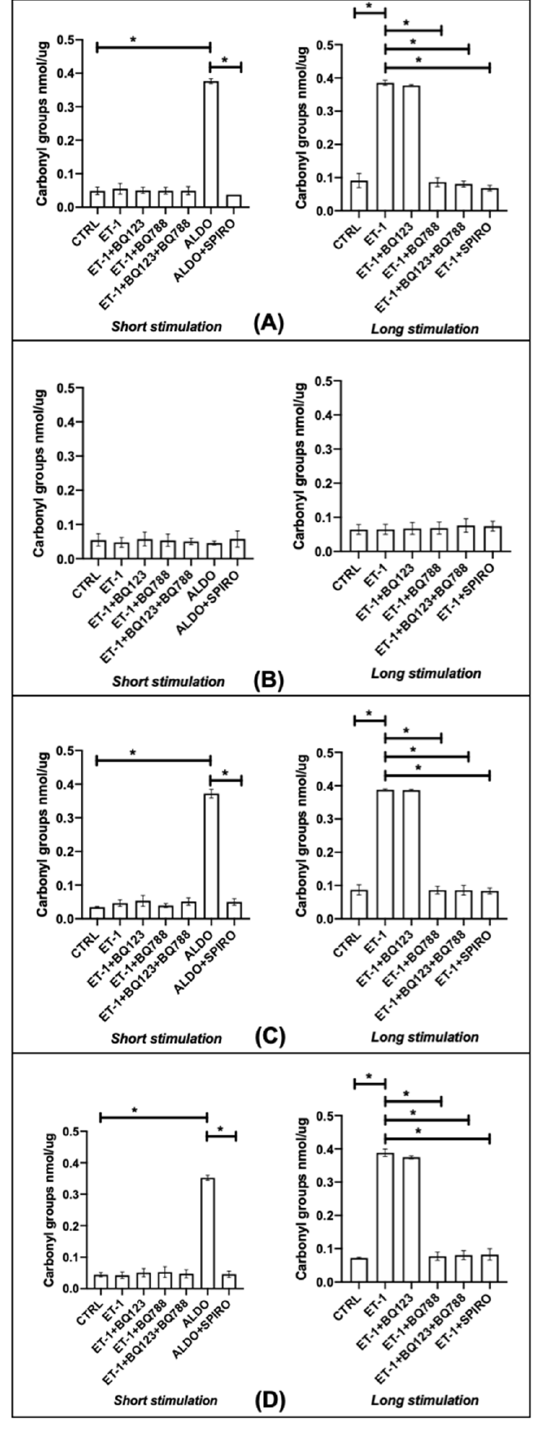
Figure 6. Protein carbonyl content assay in ( A ) HPFs, ( B ) HDFs, ( C ) lSScHDFs, and ( D ) dSScHDFs. In all cells analyzed except HDFs, the amount of carbonyl groups reported in nmol/ μ g was increased after a long ET ‐ 1 stimulation of 24 h and the antagonism of ETB (BQ788) or aldosterone (spironolactone) inhibits this effect; short aldosterone stimulation of 40 min is sufficient to promote oxidative stress. (* p < 0.05). (HPFs: human pulmonary fibroblasts; HDFs: human dermal fibroblasts; lSScHDFs: limited scleroderma dermal fibroblasts; dSScHDFs: diffuse scleroderma dermal fibroblasts; ET ‐ 1: endothelin ‐ 1; BQ123: ETA blocker; BQ788: ETB blocker; ALDO: aldosterone; SPIRO: spiroronolactone).